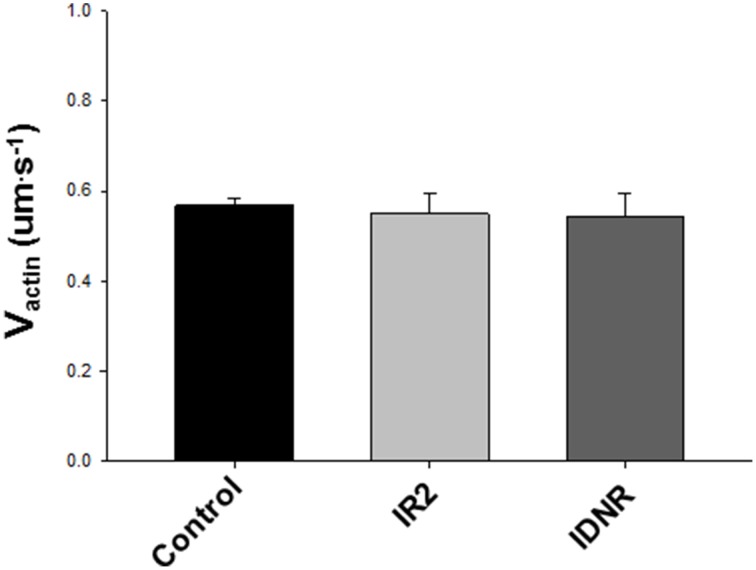
Effect of ischemia/reperfusion on Vactin. Means ± SEM for unregulated (no Tn/Tm) actin filament velocities in the in vitro motility assay using myosin isolated from the corresponding condition. The myosin used was isolated from tissue from control, ischemia with 2 h of reperfusion (IR2) and ischemia without resuscitation (IDNR). Data were analyzed using a Kruskal–Wallis ANOVA, but all comparisons were non-significant (p > 0.05). The data represent the average actin filament velocities from 106 to 30 s videos from Control, 19 from IR2 and 8, from IDNR.